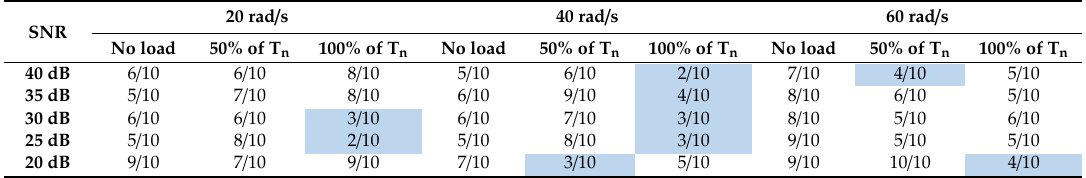
Table 3. CUSUM mean detection performances for kurtosis signal with P D > 0.8.